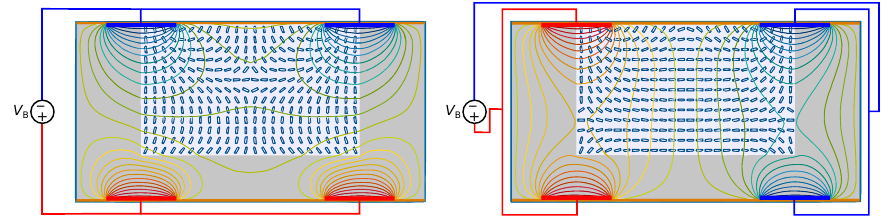
Figure 18. Simulated field distribution of the electrically biased W-band rectangular waveguide phase shifter based on LC.